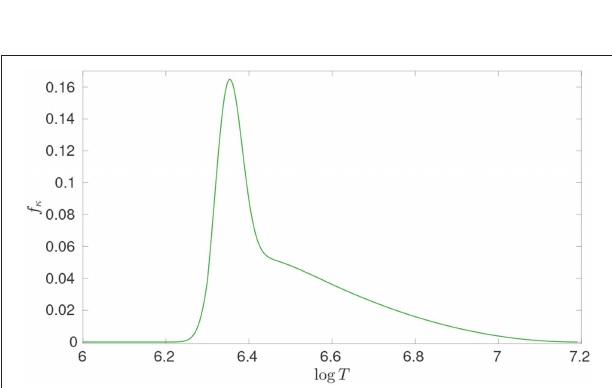
FIGURE 6 | Modification to the opacity profile used in the solar models denoted as “ Poly .” f κ ( T ) is the increase in relative opacity applied during the